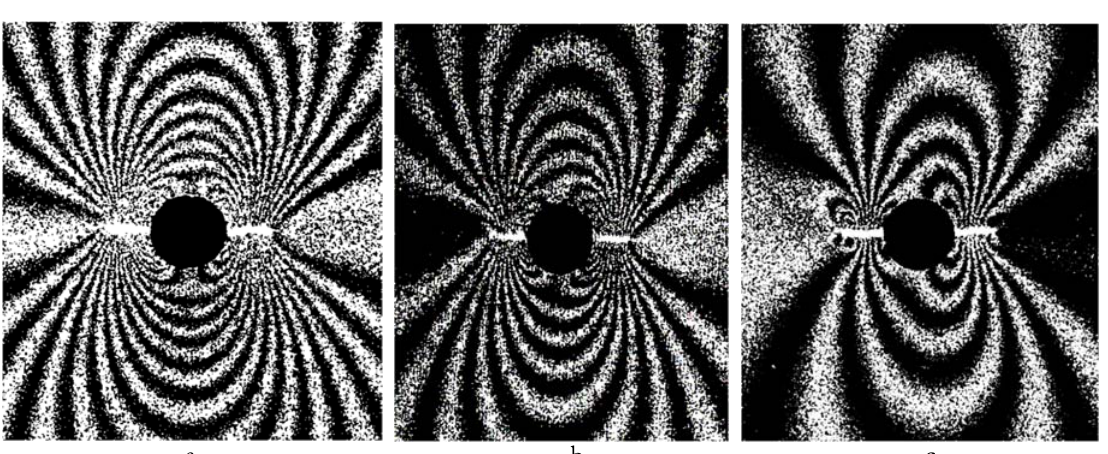
Figure 5: Interference fringe patterns obtained in terms of in-plane displacement component v for three different specimens; initial crack length 0 a = 0 mm with increment   1 a = 2.30 mm (left) and   1 a = 2.30 mm (right). a – Specimen T5_29H ( σ = 60 MPa); b –